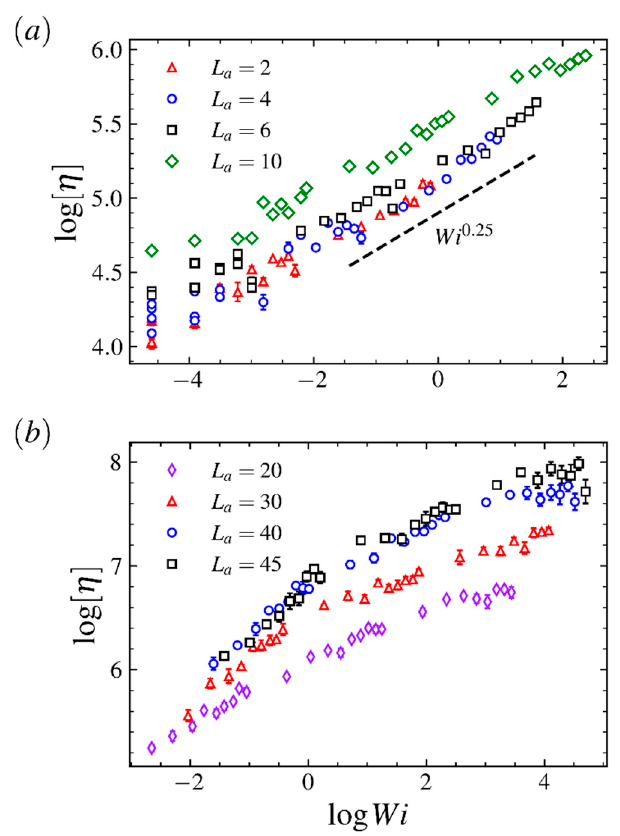
Figure 12. Intrinsic viscosity [ η ] as a function of the Weissenberg number Wi for comb polymers with ( a ) long arms and ( b ) short arms.